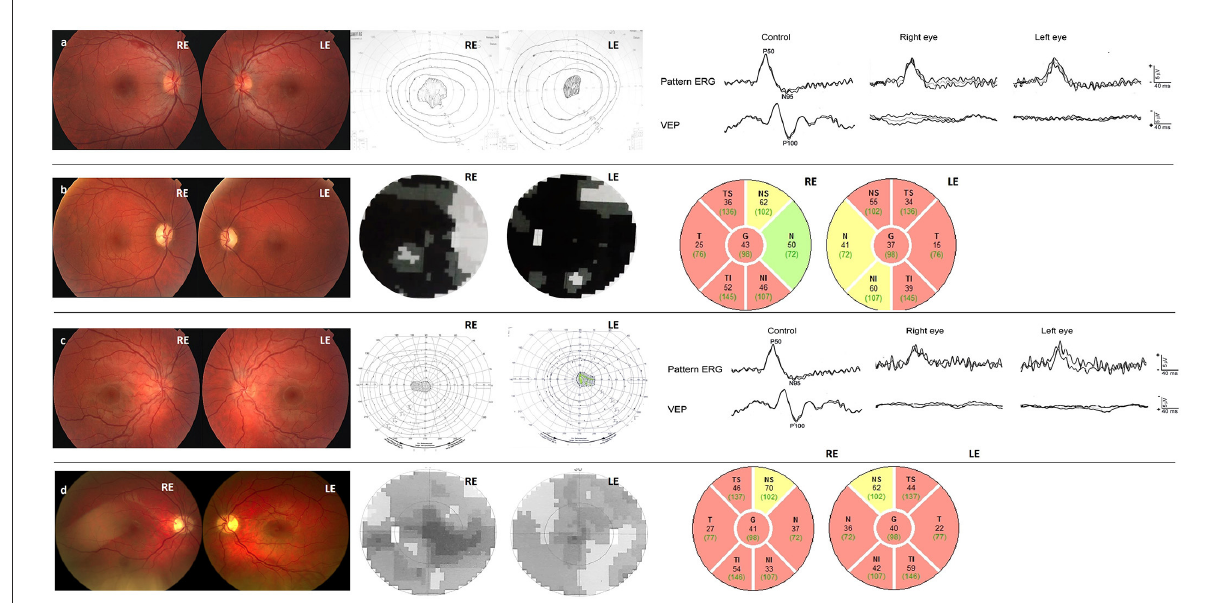
FIGURE1 (a) Case 1 Fundi at the disease onset: hyperemic optic disks, without vessel tortuosity, and with intraretinal hemorrhage at the superior arcade, central scotoma in the visual field, and normal PERG, delayed and decreased VEP 100. (b) Case 1 at the last check-up 14 years after the disease onset: pale and atrophic optic disks, small fenestrations in the central scotoma in the visual field, and thinning of the peripapillary RNFL. (c) Case 2 Fundi at the disease onset: Hyperemic optic disks, tortuotic blood vessels, central scotoma in the visual field, reduced PERG N95, delayed and decreased VEP 100. (d) Case 2 at the last check-up 12 years after the disease onset: Pale and atrophic optic disks, decreased visual field scotoma, and thinning of the peripapillary RNFL despite significant VA improvement.